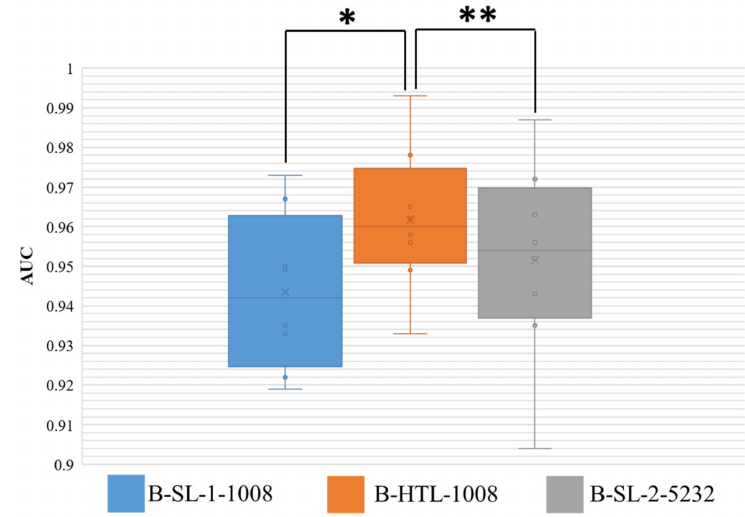
Figure 6. AUC distribution of three models on Dataset-BRE. The ** denotes no statistically significant difference, while * denotes a statistically significant difference. The boxes indicate the upper and lower quartile values, and the whiskers indicate the minimum and maximum values. The horizontal bar in the box indicates the median, while the cross indicates the mean AUC. The circles represent data points, and the scatter dots indicate outliers.